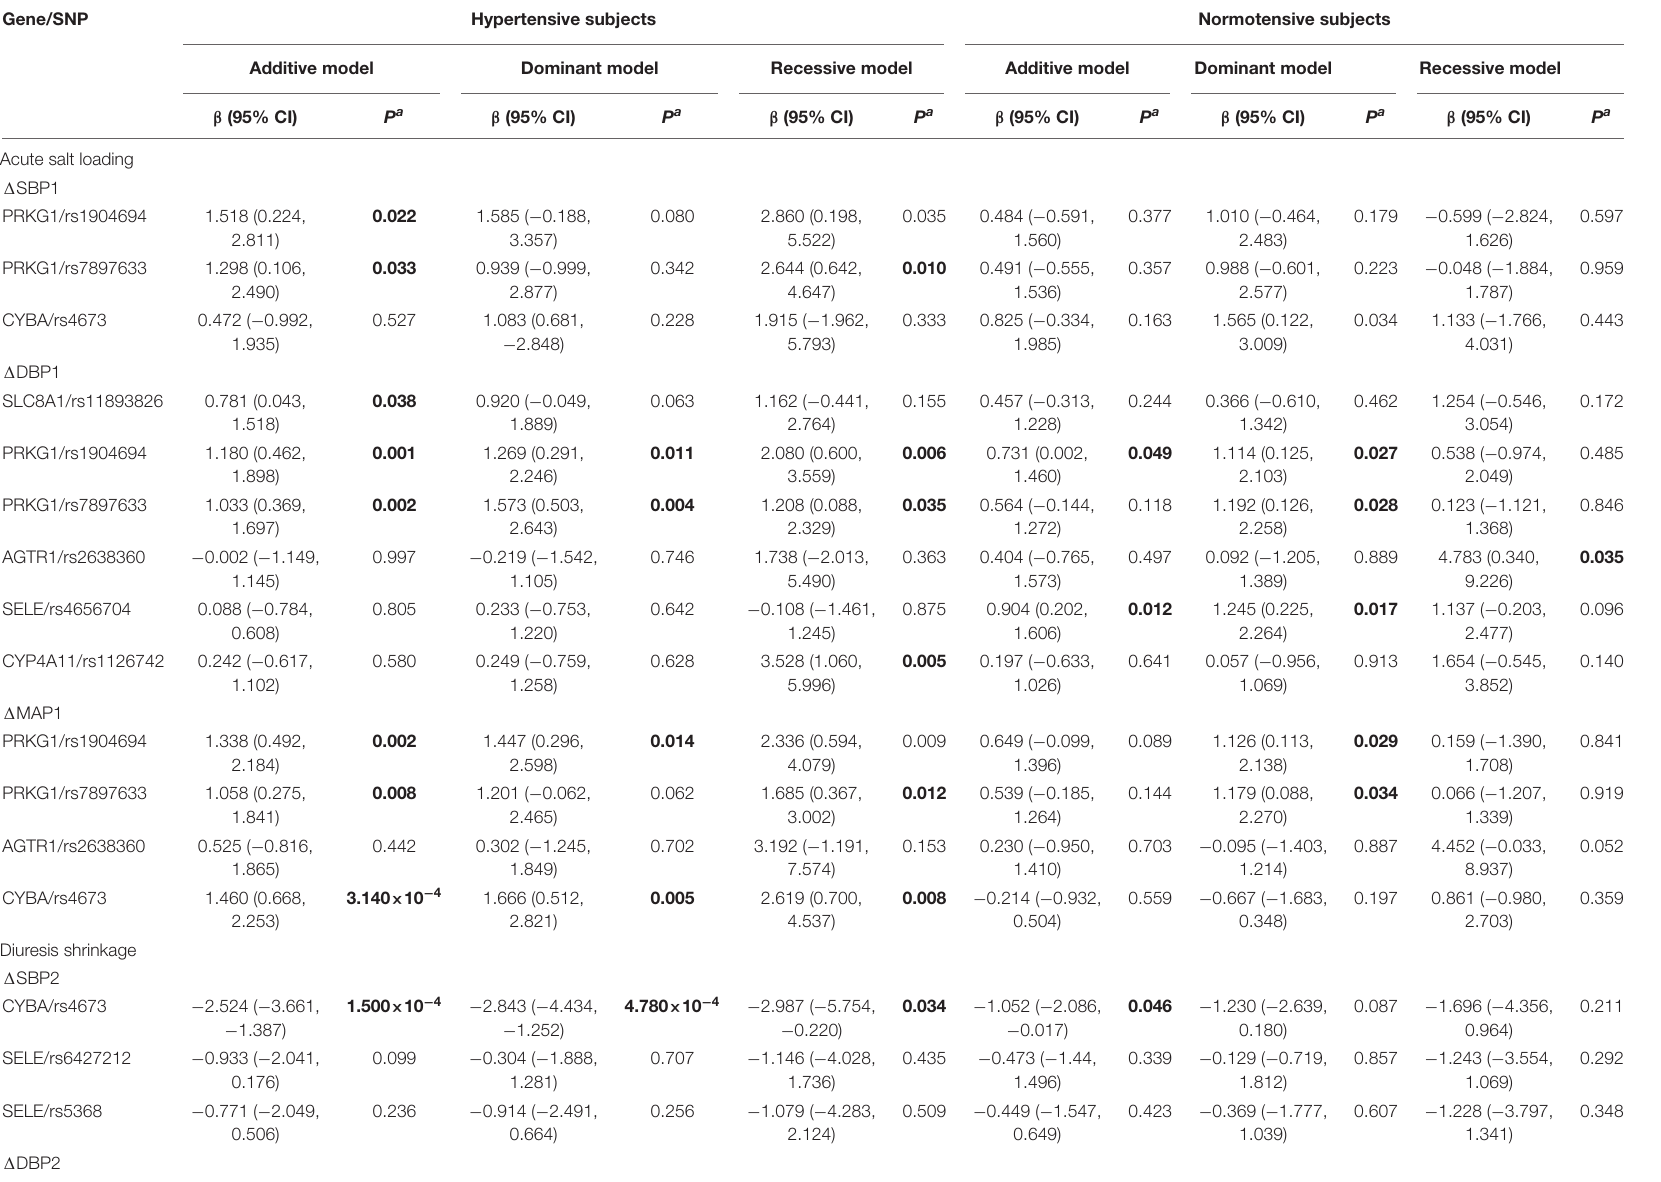
TABLE 3 | Associations between SNPs and BP change after acute salt loading and diuresis shrinkage stratified by hypertension